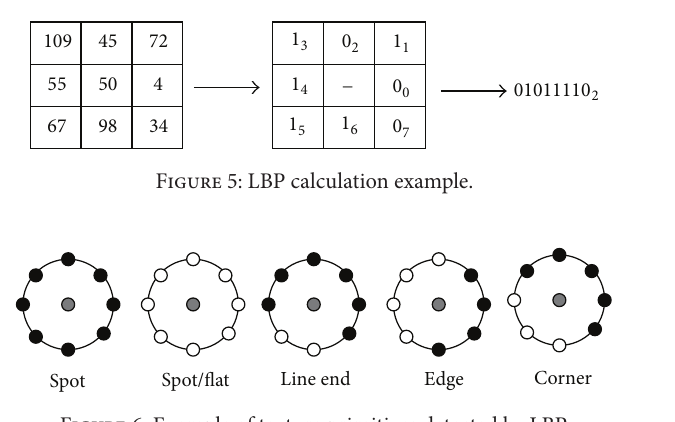
Figure 6: Example of texture primitives detected by LBP.